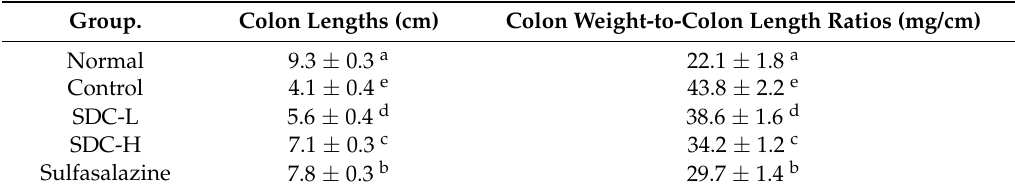
Table 10. Colon lengths and colon weight-to-colon length ratios.